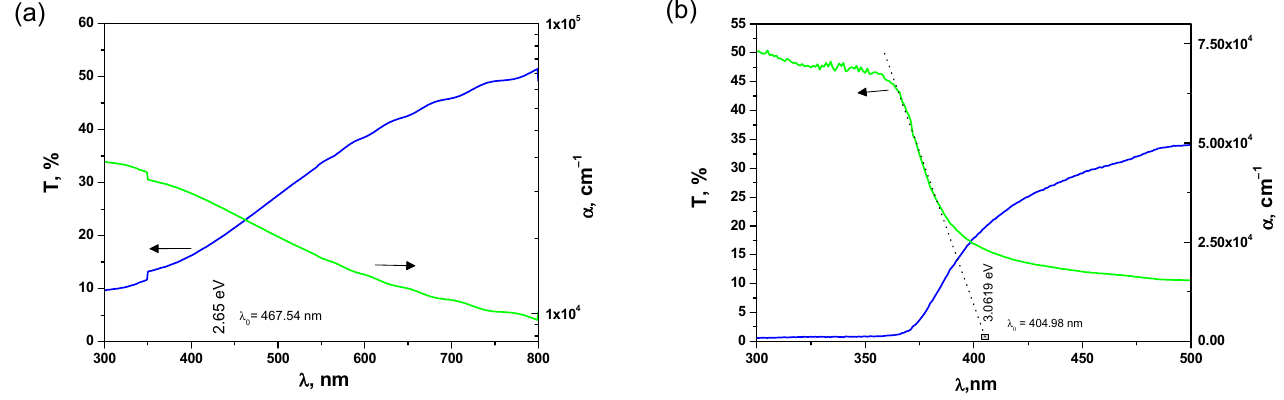
Figure 7. ( a , b ) Spectra for calculations of NEAR coefficients as grown ( a ) and annealed in 400 °C ( b ) thin layer of ZnO:Co.